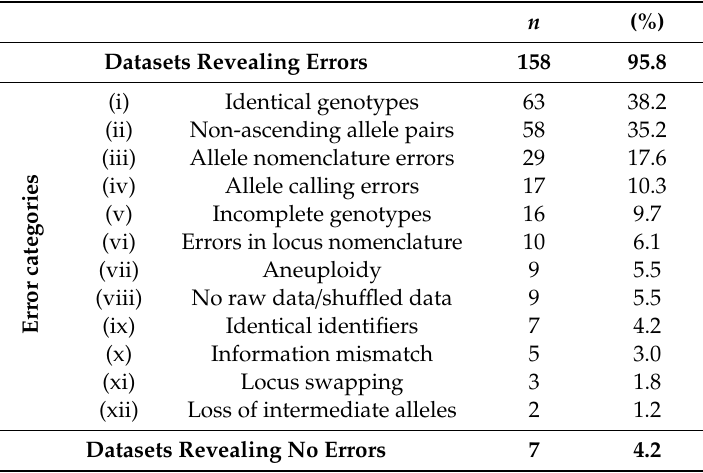
Table 2. Statistics of errors found in the 165 autosomal STR datasets generated by capillary electrophoresis (CE) and submitted to STRidER in its first two